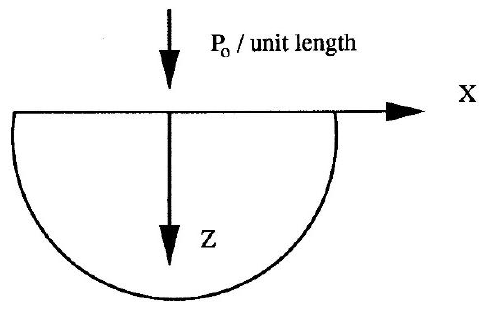
Figure 1. Concentrated line load applicable to magneto-piezoelastic medium with free